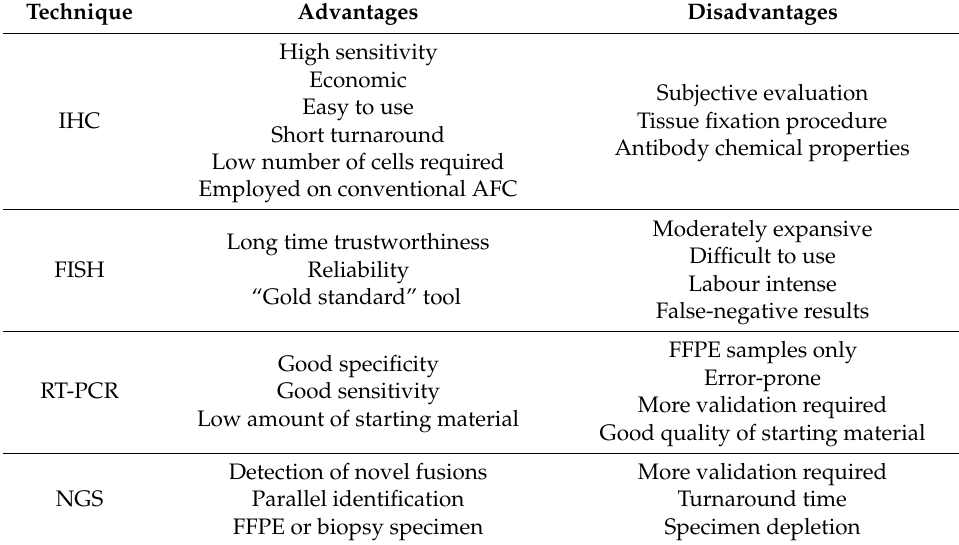
Table 3. Techniques for the detection of ROS1